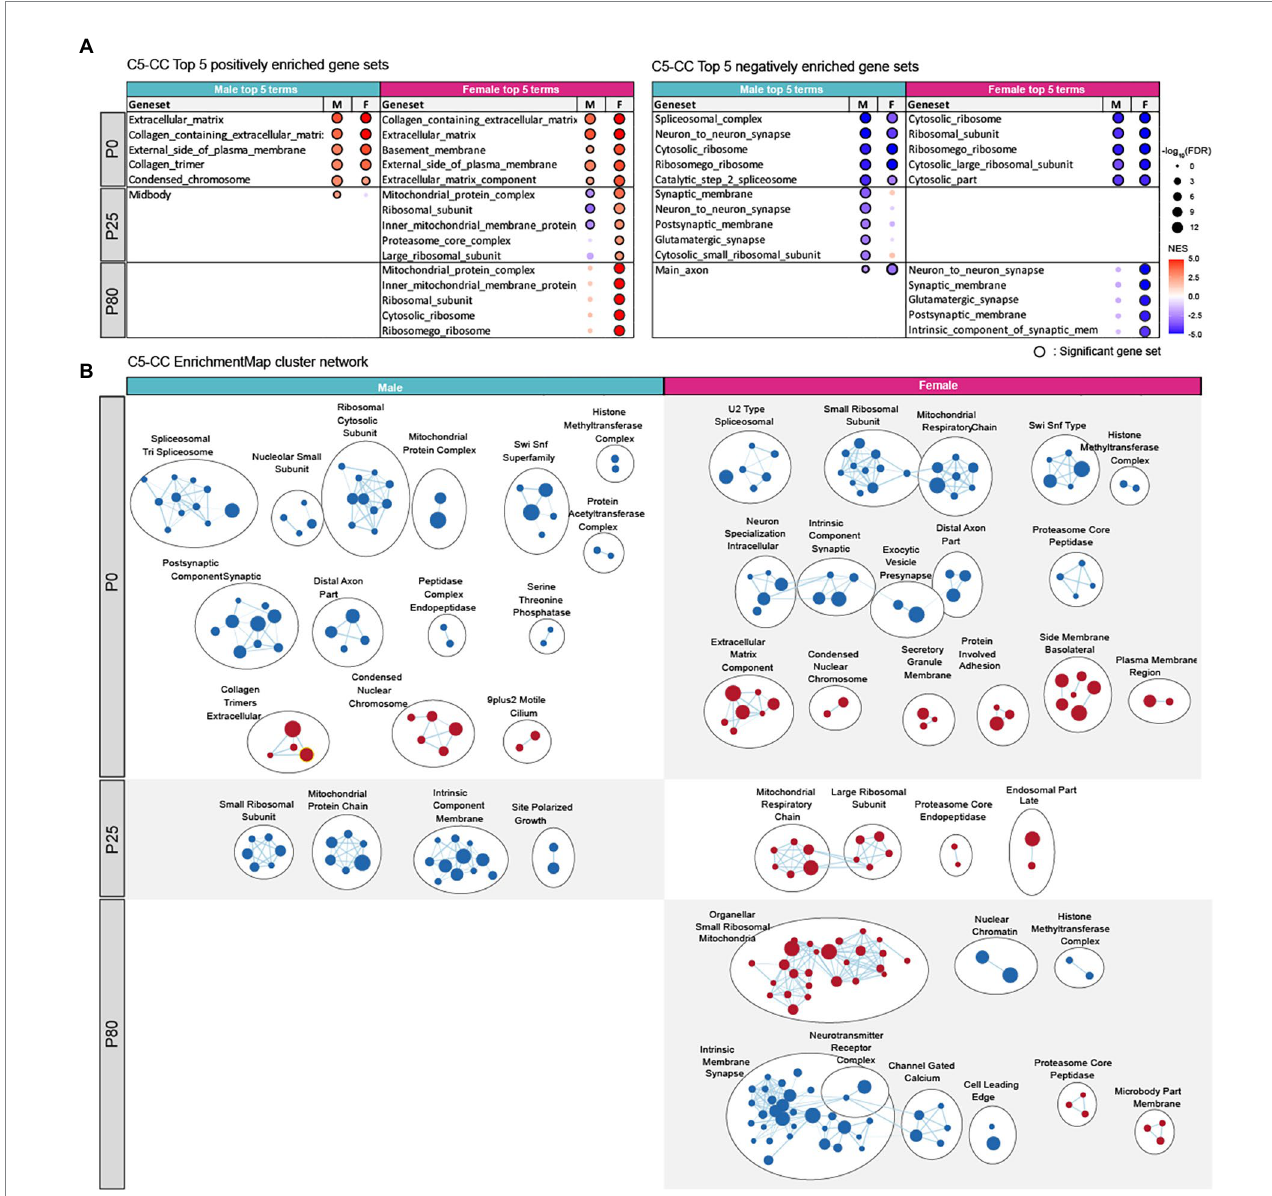
FIGURE 5 Biological functions differentially altered in male and female Chd8 +/S62X transcriptomes. (A) GSEA of P0, P25, and P80 male and female HT/WT transcripts for gene sets in the cellular components (CC) domain of the C5 database (http://software.broadinstitute.org/gsea). Top-five gene sets positively (red circles) or negatively (blue circles) enriched in male or female transcripts are listed, together with the same gene sets in the other sex and their enrichment levels (see Supplementary Tables S5–S7 for full results). ( n = 3 mice for P0/P25/P80 male/female mice, FDR (false discovery rate) < 0.05; NES, normalized enrichment score). (B) Integration and visualization of enriched genes in larger clusters using Cytoscape EnrichmentMap. ( n = 3 mice for P0/25/80 male/female mice; node cutoff, FDR < 0.05 and p < 0.001; edge cutoff, overlap coefficient >